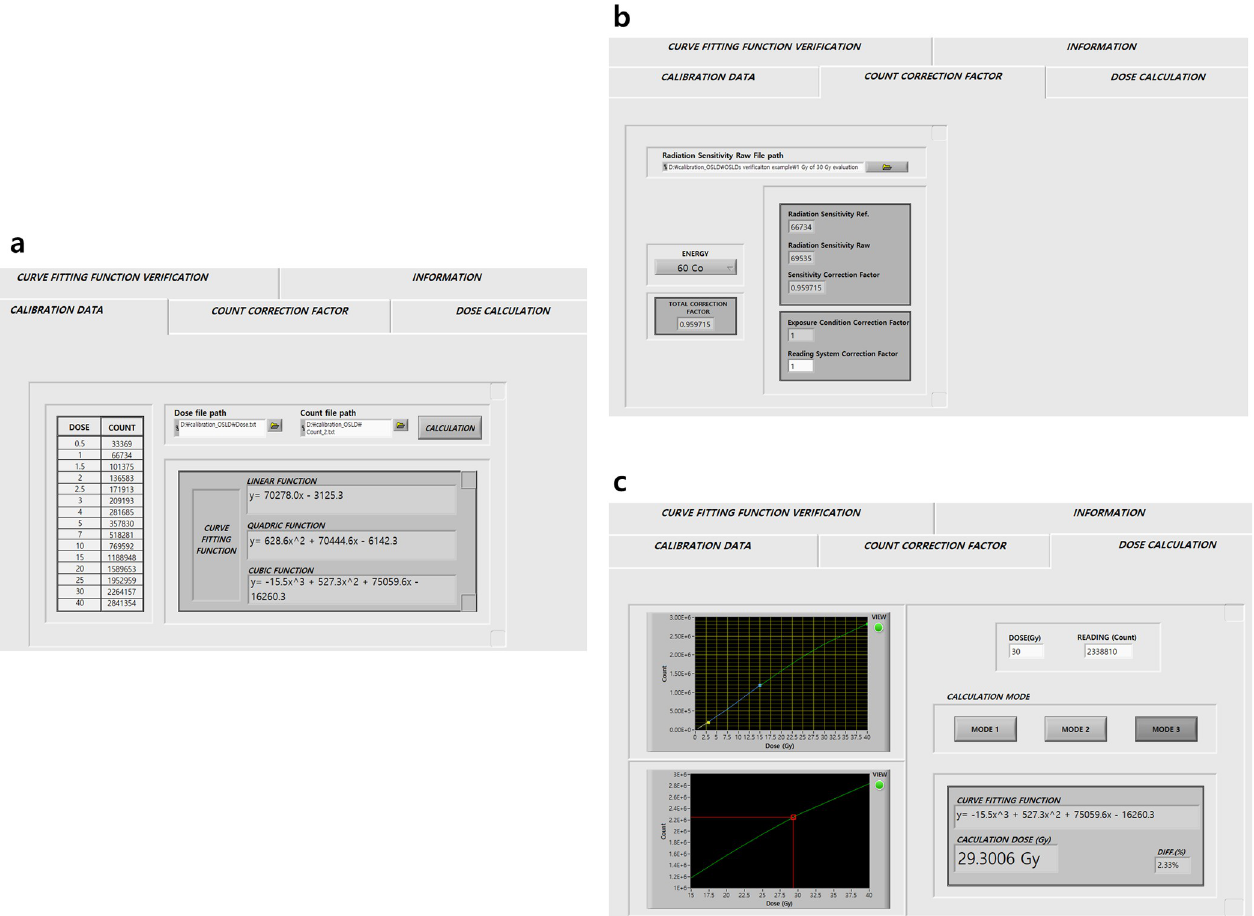
Fig 5. GUI of the OSLD dose evaluation program (example for 30 Gy). (a) Information entered to determine the dose-response curve and fitting function according to the dose range, (b) count corrected using the correction factor from the raw count, and (c) dose evaluation result for the corrected count using the